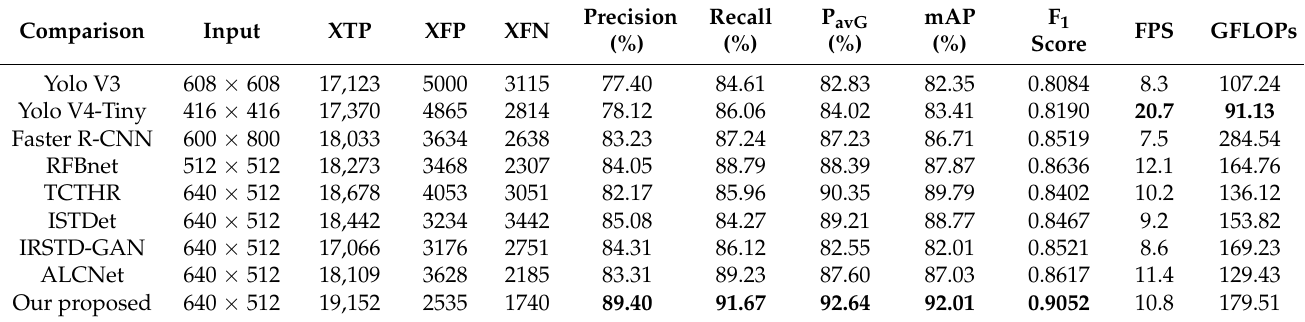
Table 4. Comparison of the state-of-the-art target detection